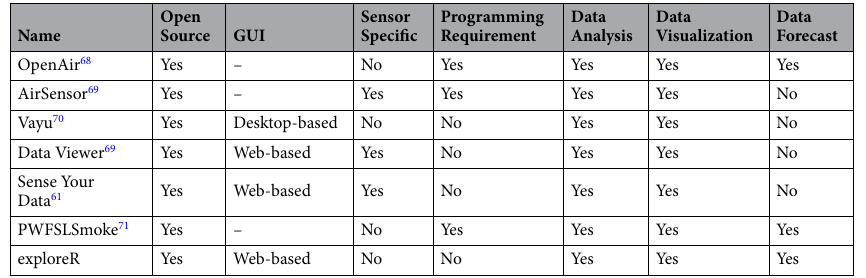
Table 3. Comparison of exploreR with other air quality data analysis tools and